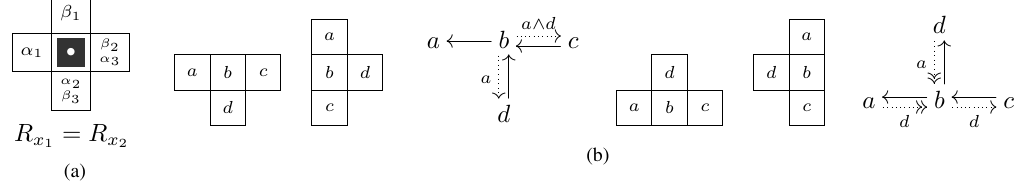
Figure 18: (a) A (2 , 4) priority strategy for the breaker for P 4 , 3 (b) Dependency digraph of the cells in the orientations of P 4 , 3 .